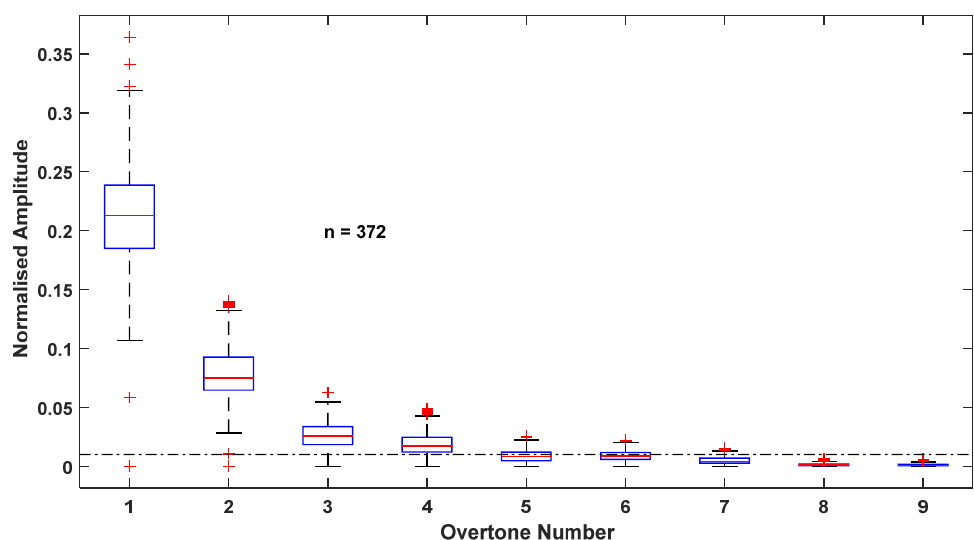
Figure 5. Amplitudedistributionoffirstnineovertonesofalltrialsnormalizedtothefundamentalamplitude. Figure 5. Amplitude distribution of first nine overtones of all trials normalized to the fundamental amplitude. Based on this observation, the thigh angle waveform for each trial was reconstructed using (1) with the coefficients of the first five harmonics extracted from the same